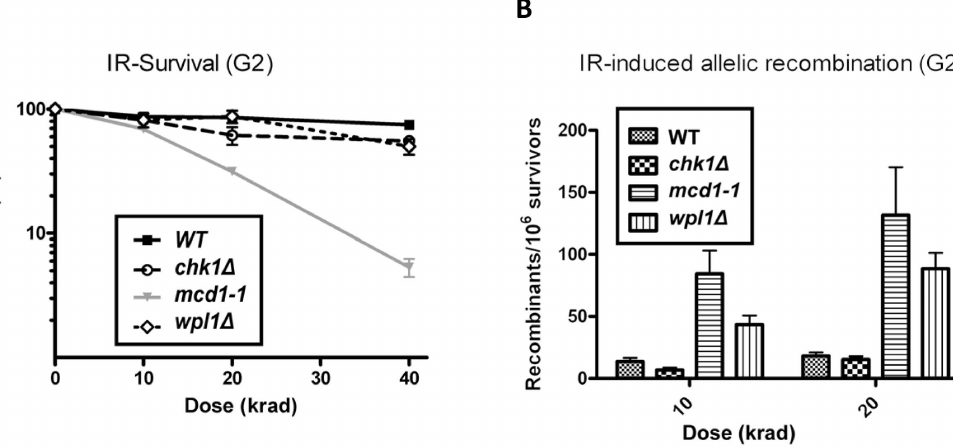
Fig. 2. Survival and allelic recombination in G2-arrested cells treated with ionizing radiation. A. G2 arrested haploid cells were irradiated with IR (see [20] and Materials and Methods) with the indicated doses and spread over YPDA plates to determine survival. B. Similarly, G2 arrested diploid cells were irradiated. IR- induced TYR1 recombination was determined as previously described